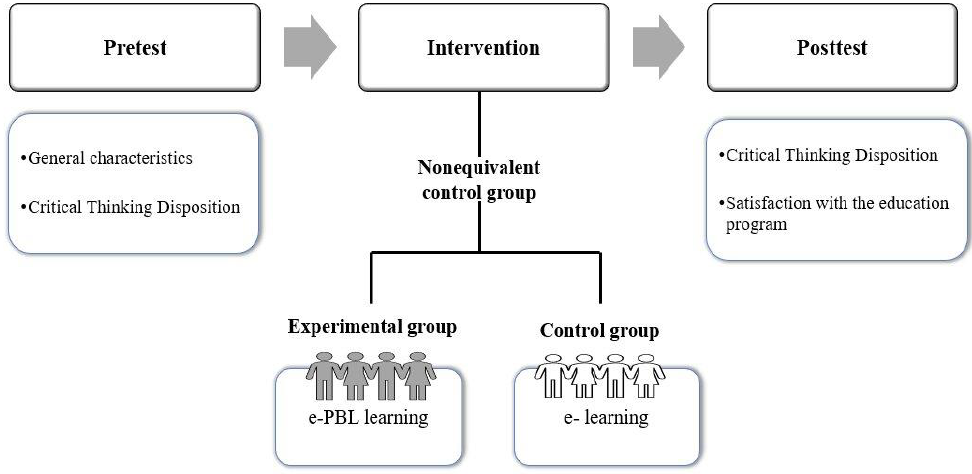
Figure 2. Experimental design.